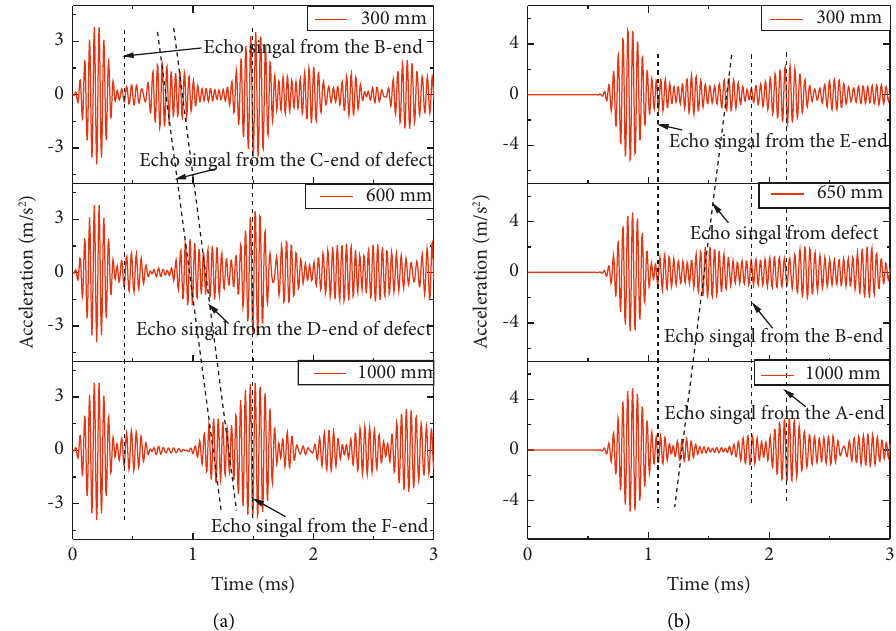
Figure 10: The wave propagation signal in the rock bolt with one bond defect at different locations without load: (a) A-end and (b) F-end.